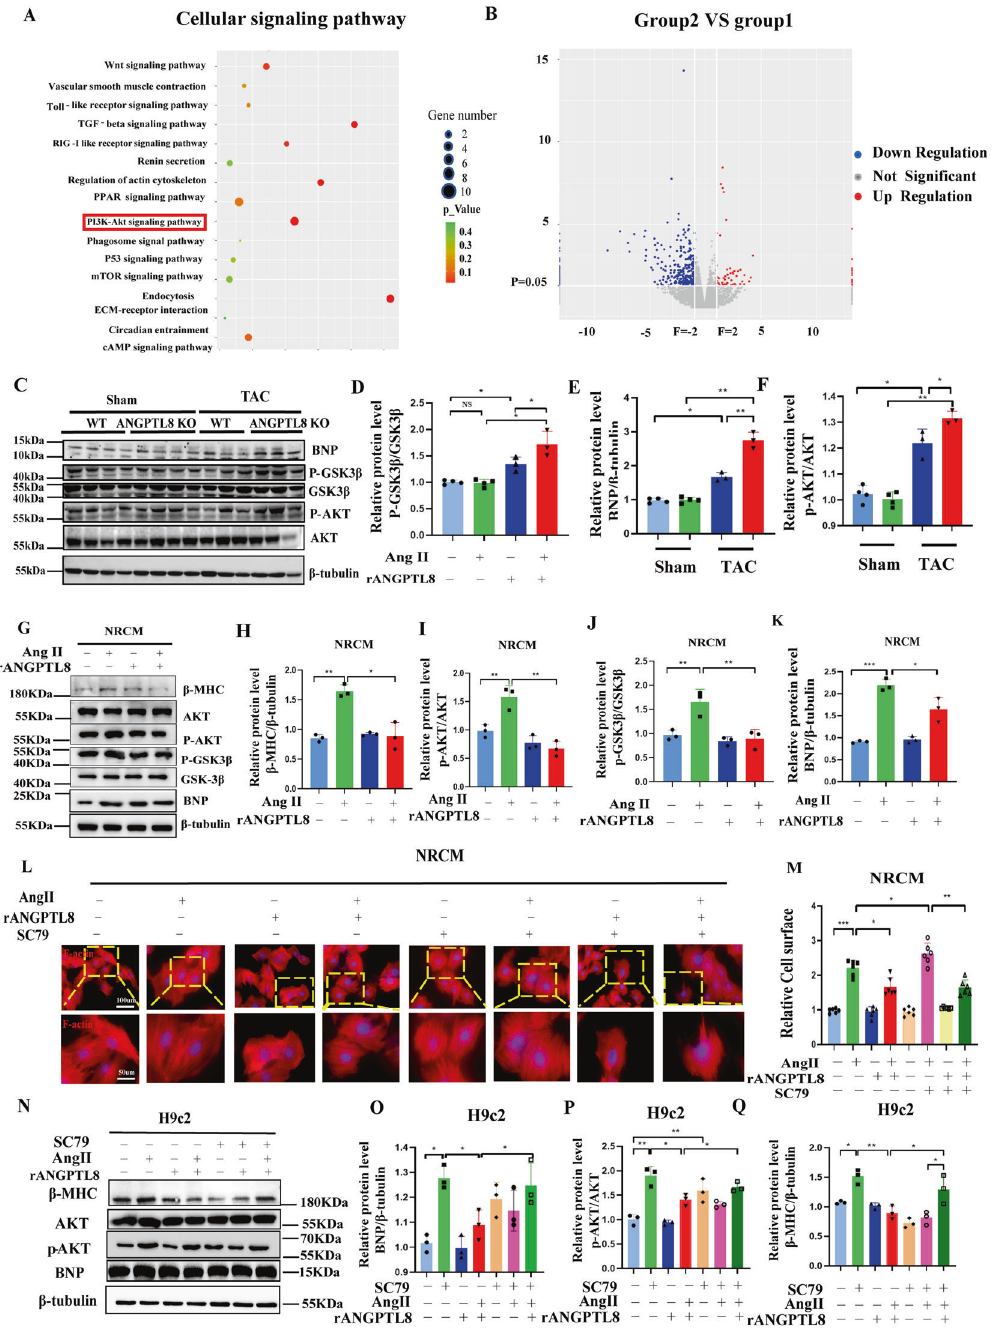
Fig. 7 Effects of ANGPTL8 on the Akt/GSK-3 β signaling pathway. A Kyoto Encyclopedia of Genes and Genomes pathway enrichment analysis of the identi fi ed differentially expressed genes based on RNA-seq data set from the hearts of wild-type (WT) or ANGPTL8 KO mice at 4 weeks after Ang II infusion ( n = 3 in each group). B Volcano plot of relative RNA expression from the hearts of WT mice infused with Ang II for 4 weeks compared to ANGPTL8 KO mice. Genes in the upper left and right quadrants are signi fi cantly differentially expressed (microarray, n = 2 per group). C – F Western blots and quanti fi cation of BNP and total and phosphorylated levels of GSK-3 β and Akt proteins in cardiac tissues from WT and ANGPTL8-KO mice subjected to sham ( n = 4) or TAC ( n = 3). G – K The effect of rANGPTL8 on NRCM hypertrophy induced by Ang II and Western blotting was used to detect the hypertrophic markers β -MHC and BNP and the total and phosphorylated protein levels of GSK-3 β and Akt. Representative western blots ( G ) and quantitative results ( H – K ) of these hypertrophic markers and signaling proteins ( n = 3 in each group). L Microscopy images of NRCM hypertrophy treated with rANGPTL8 or the Akt activator SC79 (scale bars, 100 μ m and 50 μ m, respectively). M Quantitative data of the cell surface of NRCMs in the indicated groups ( n > 50 cells in each group, 6